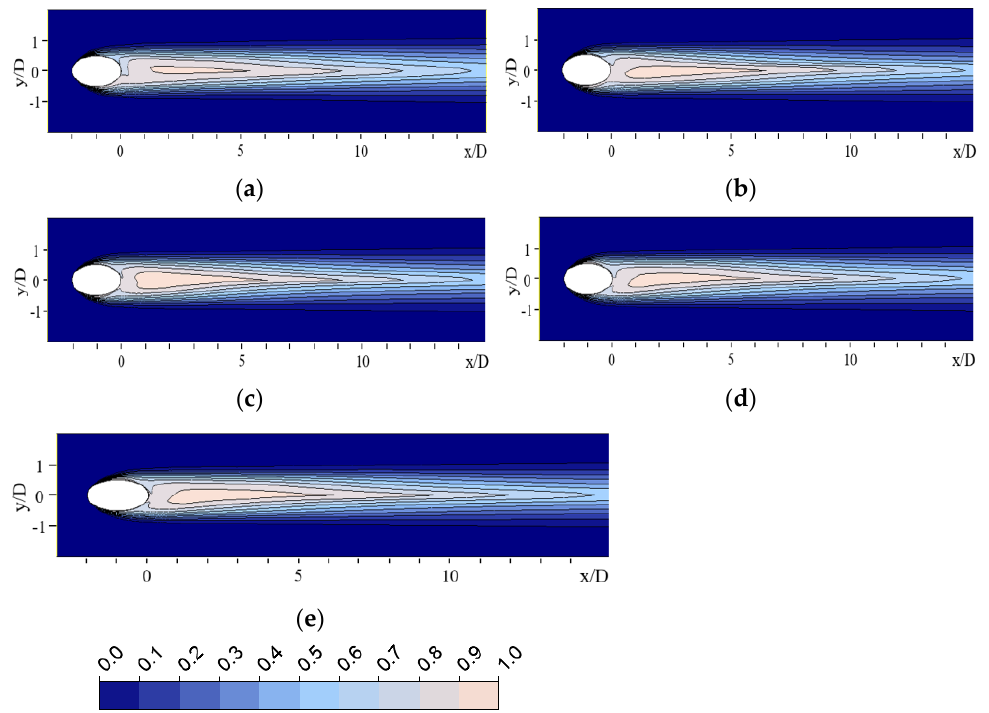
Figure 12. FE distributions on the x-y plane at z/D = 0: ( a ) reference, ( b ) F1 = 1.5D, ( c ) F1 = 2D, ( d ) F1 = 2.5 € ( e ) F1 = 3D.